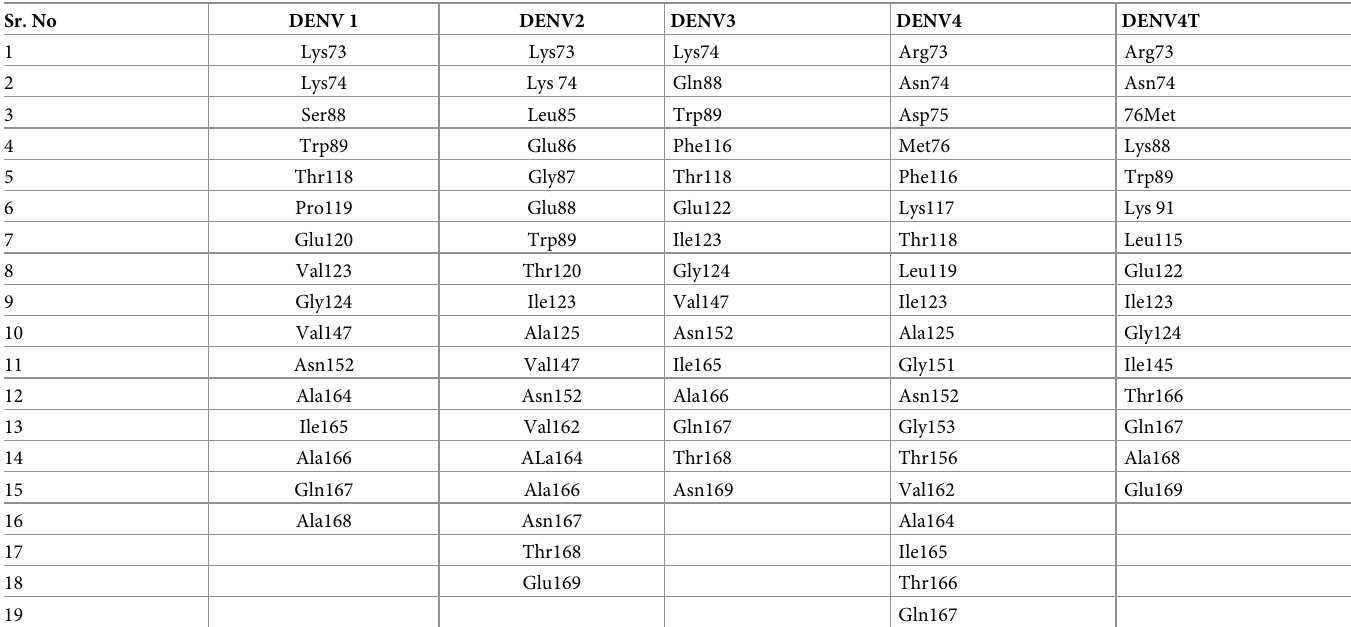
Table 3. Interaction of dabrafenib with all 5 DNV